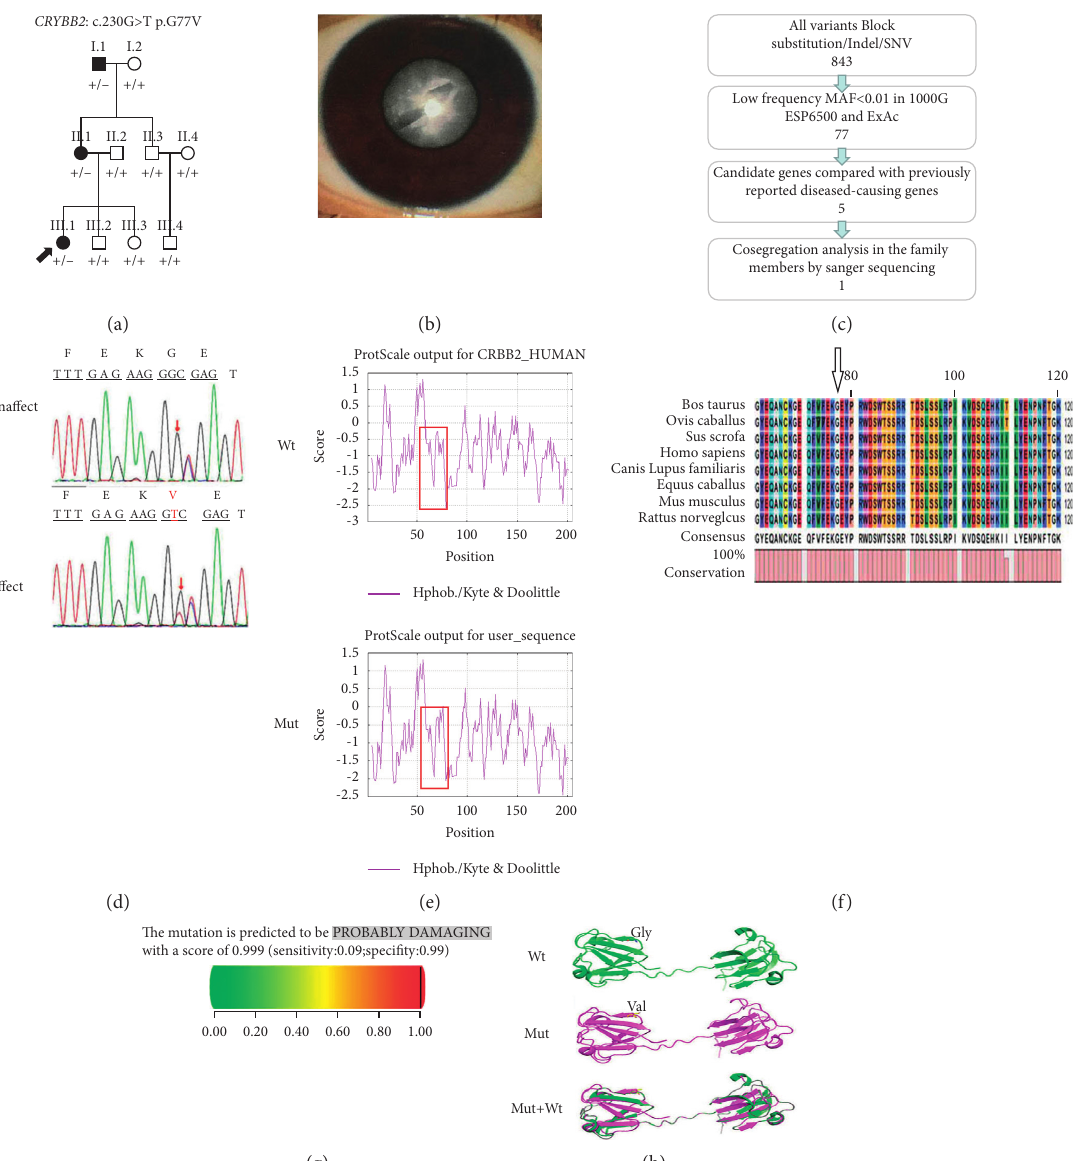
Figure 1: (a) Pedigree of ADCC family A Squares and circles indicate males and females, respectively. The solid black arrow indicates the proband (III.1). (b) A photograph of the proband’s (III.1) lens is shown. (c) Schematic representation of the filter strategies employed in our study. (d) Sanger sequencing results. (e) Hydropathic characteristics caused by changes in the variant protein. (f) Multiple protein sequence alignment. (g) The score obtained from PolyPhen-2 analysis was 0.999. (h) The structures of the homomeric WT and variant CRYBB2 c.230G > T; p.G77V proteins were modelled in